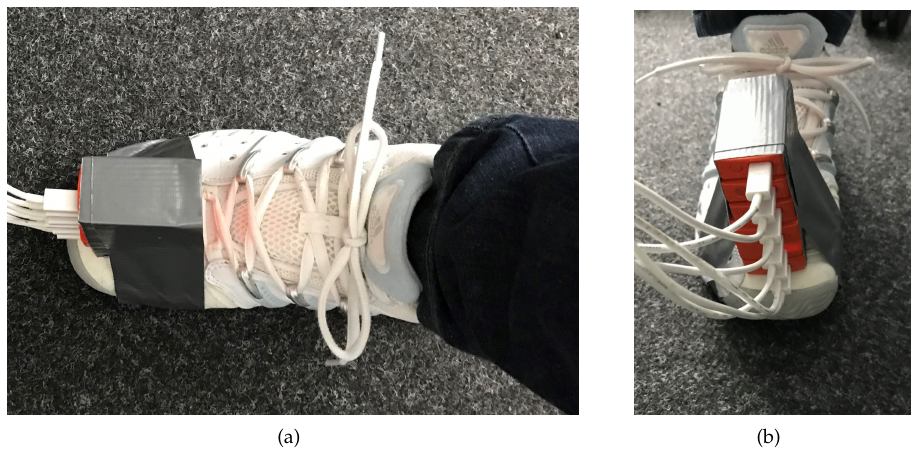
Figure 2. Six Xsens sensors mounted on the foot of the pedestrian; ( a ) top view and ( b ) front view of the 6